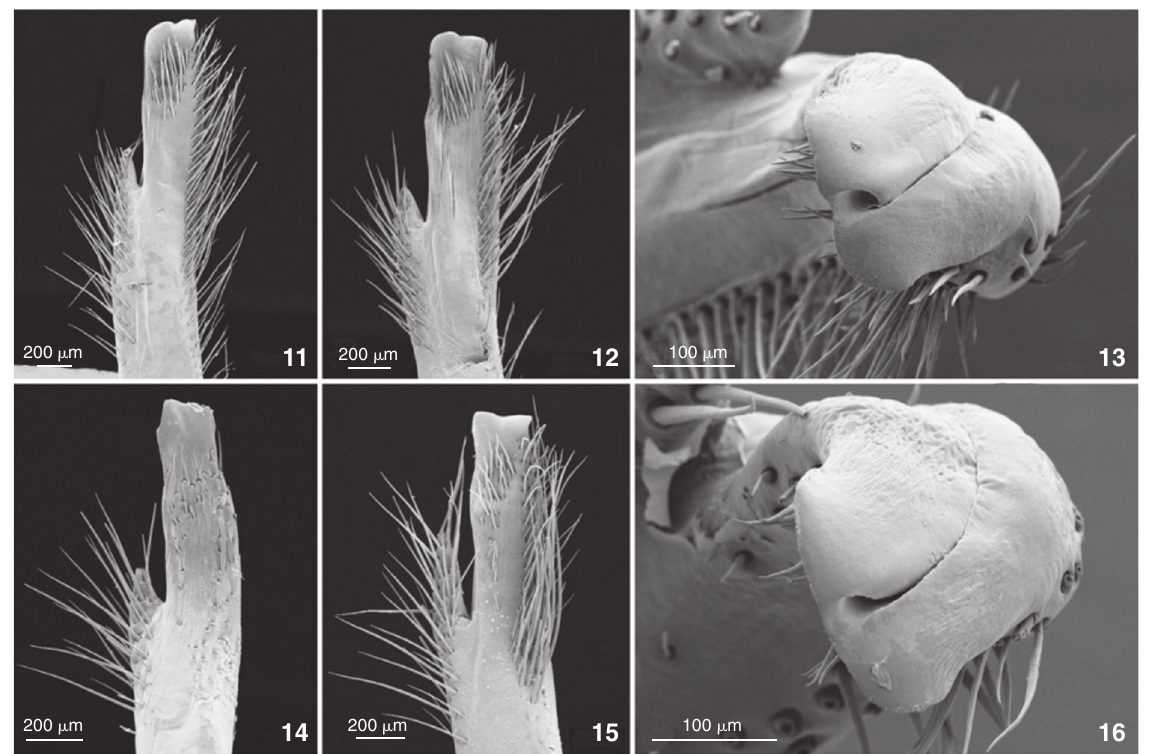
Figures 11-16. Scanning electron micrographs of the right gonopods of U. panacea (11-13) and U. pugilator (14-16). (11) USNM 150098, paratype, Panacea, Florida, carapace width 16.5 mm; (12-13) USNM 180188, Mexico, Laguna La Mancha, carapace width 18 mm; (14) USNM 55553, United States, Virginia, carapace width 16 mm; (15) USNM 6440, United States, Pine Key, Florida, carapace width 23 mm; (16) USNM 17186, United States, South Carolina, carapace width 15.5